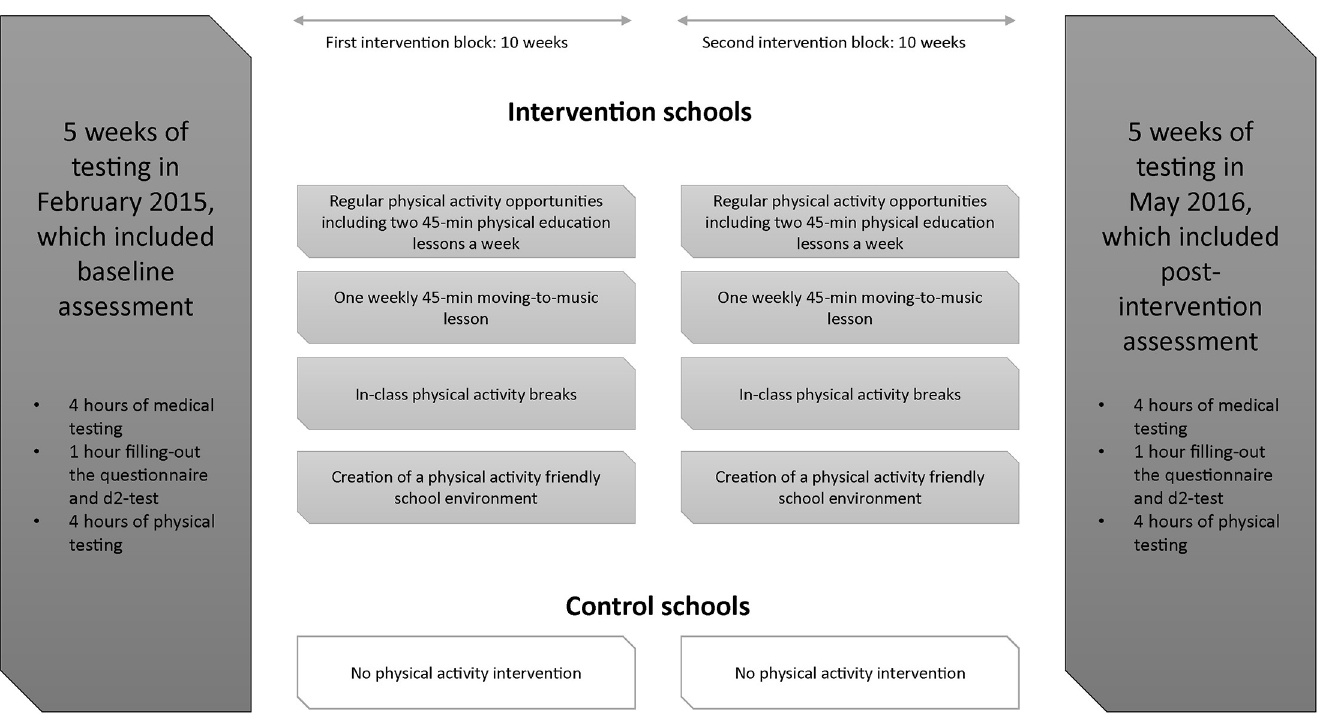
Fig 2. Overview of study design and the 20-week physical activity intervention, Port Elizabeth, South Africa carried out between February 2015 and May 2016.